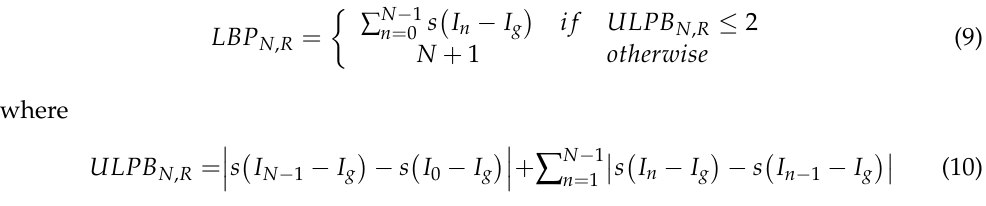
Figure 6. Preprocessing steps ( a ) grayscale image, ( b ) image denoising, ( c ) segmentation, ( d ) isolated removal, and ( e ) thinning and skeletonization.